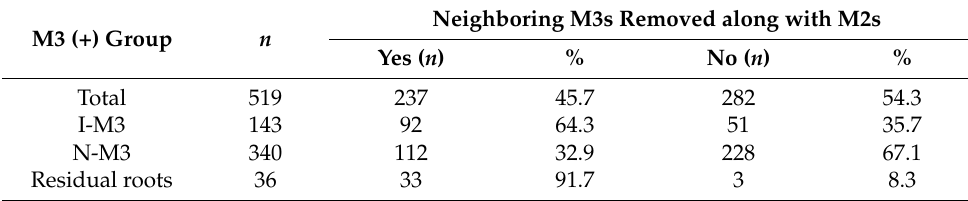
Table 4. The rate of M3 removal in M2 extraction surgery ( n =